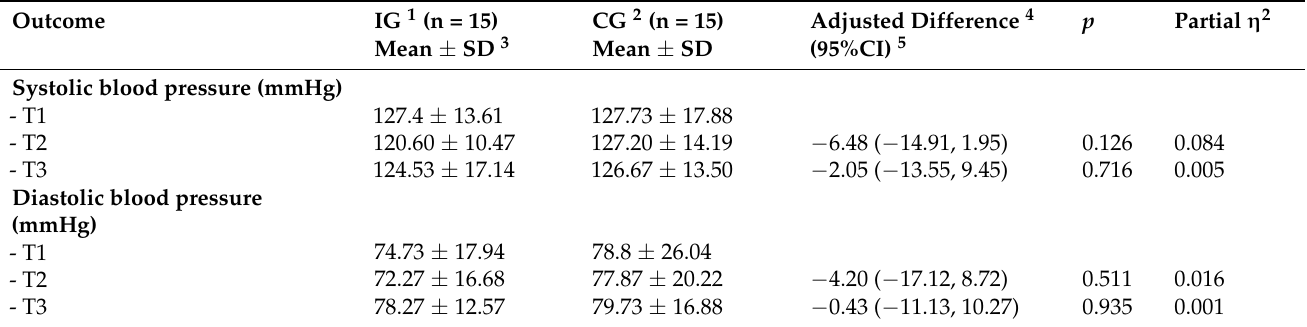
Table 8. Between-group differences in blood pressure.